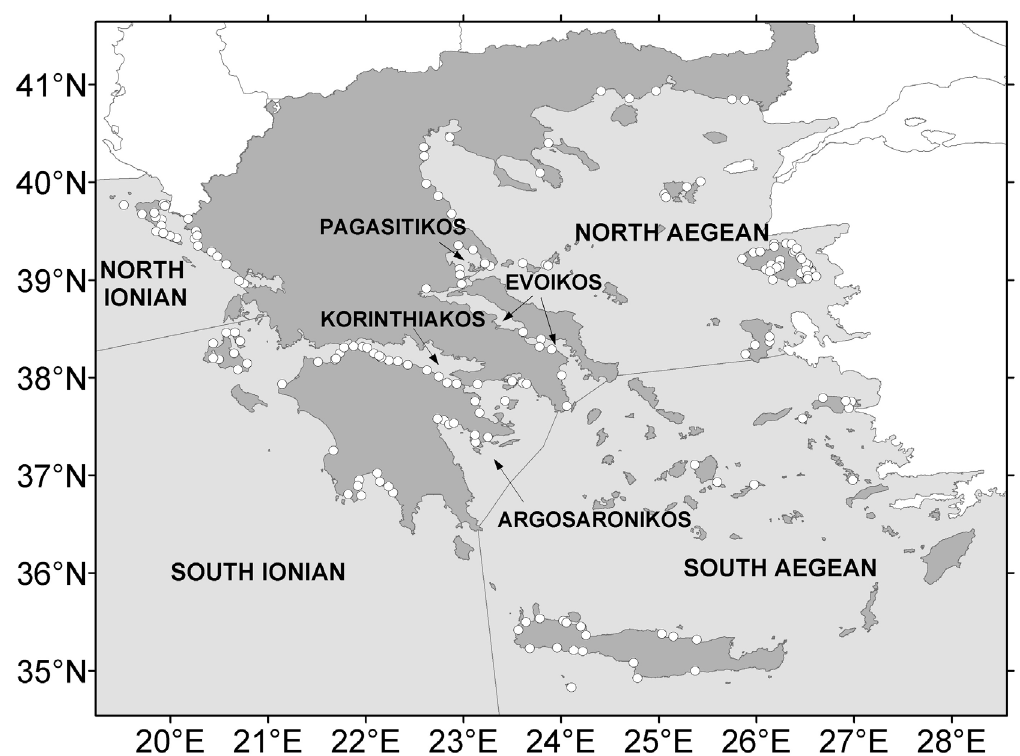
Fig . 1. – Map of Greece, with the main areas mentioned in the text. the sampling ports are marked with white bullets.